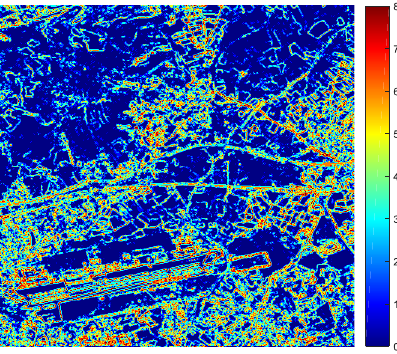
Figure 2: The pseudo-image of R-band of Rasat test image for